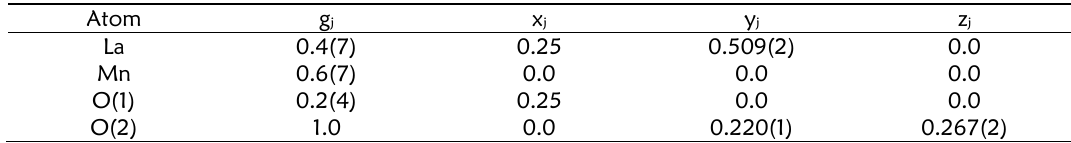
Table 9. The coordinates of atomic fractions (x j , y j , z j ), and atomic occupancy factor (g j ) of S0 sample based on neutron diffraction data.